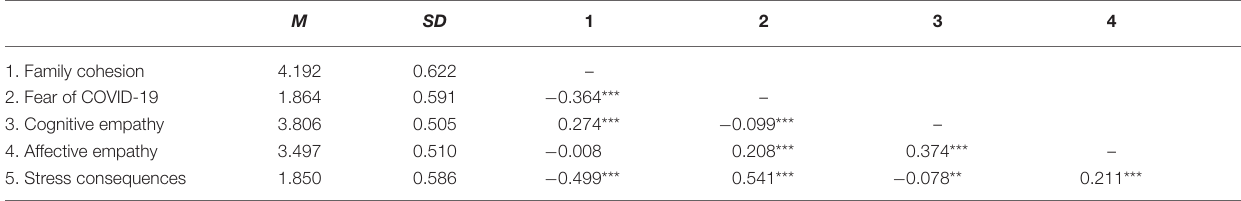
TABLE 1 | Means, standard deviations, and correlations of the main study variables.